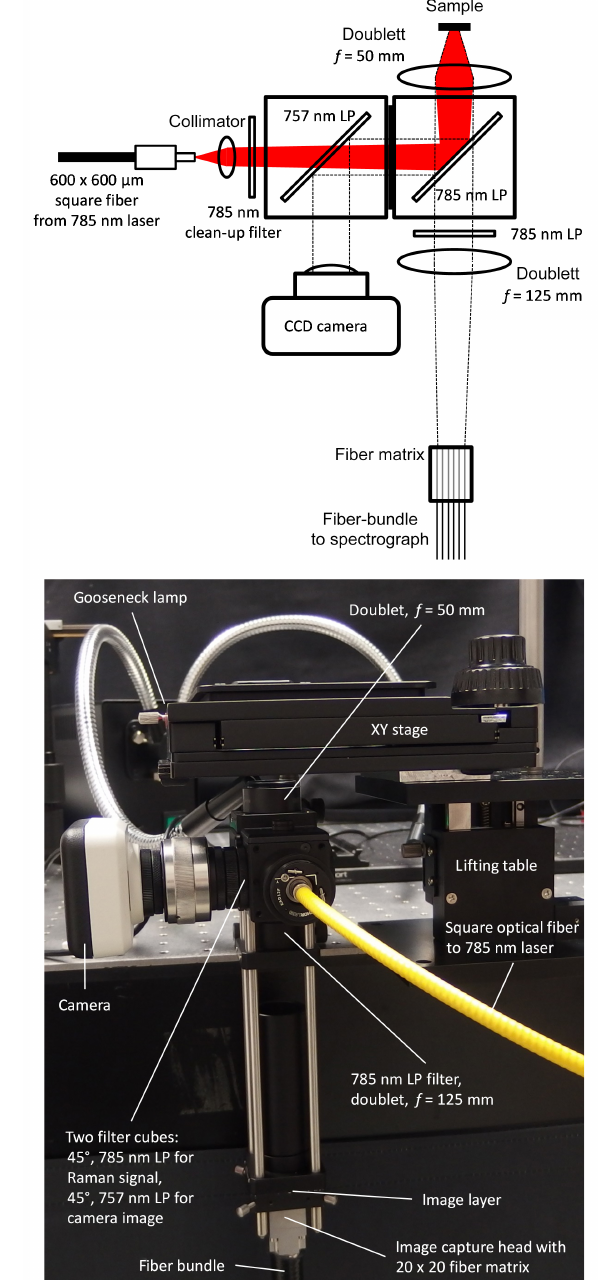
Figure 4. Design and photo of image acquisition optic AO1 suitable for a square image field with 3.6mm side length.